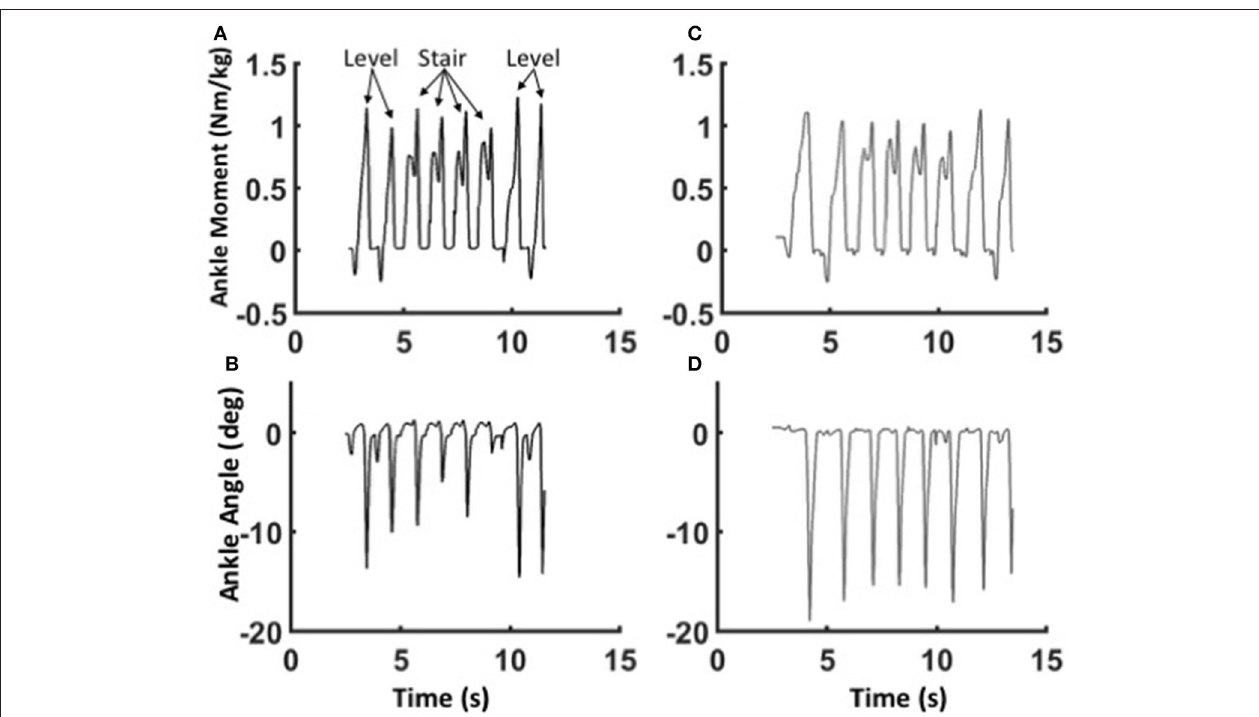
figure. The subject first takes two strides on level ground, then ascends four stairs on the prosthetic side, and finally takes two level strides at the top of the stairs. For the WFH controller, there is no change in muscle activation or other parameters during transitions from level walking to stair ascent and back to level